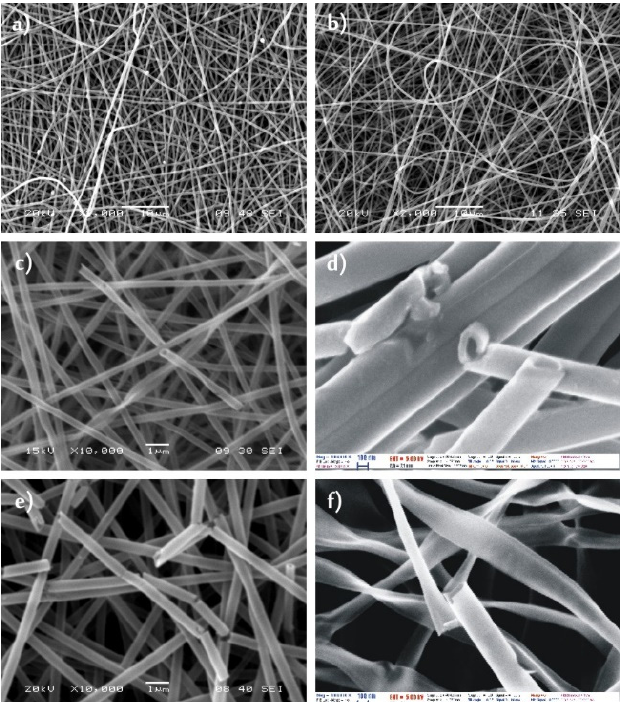
Figure 1. SEM images of ( a ) PVA nanofibers; ( b ) PVA/TiO 2 composite nanofibers, ( c , d ) TiO 2 nano- tubes obtained from the PVA/TiO 2 composite by dissolution, ( e , f ) TiO 2 nanotubes obtained from the PVA/TiO 2 composite by annealing.